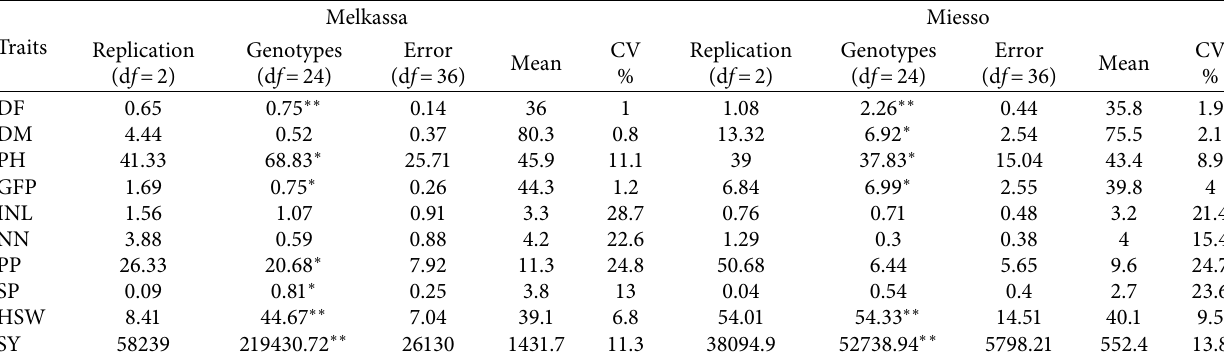
Table 3: Analysis of variance for various traits of the common bean genotypes at Melkassa and Miesso in the 2018 cropping season. Melkassa Miesso Traits Replication